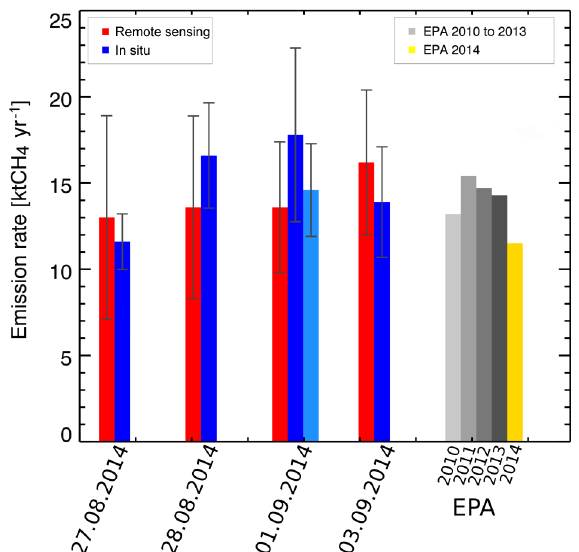
Figure 10. The bar chart shows the derived emissions and inven- tory values. The first four sets of bars depict the derived emissions from this study based on the remote sensing (red), in situ (blue; on 1 September 2014: dark blue is downwind wall 1 and bright blue is downwind wall 2) measurements, and their related errors (vertical bars). The fifth set shows the EPA inventory values for the years 2010 to 2013 (grey shaded) and 2014